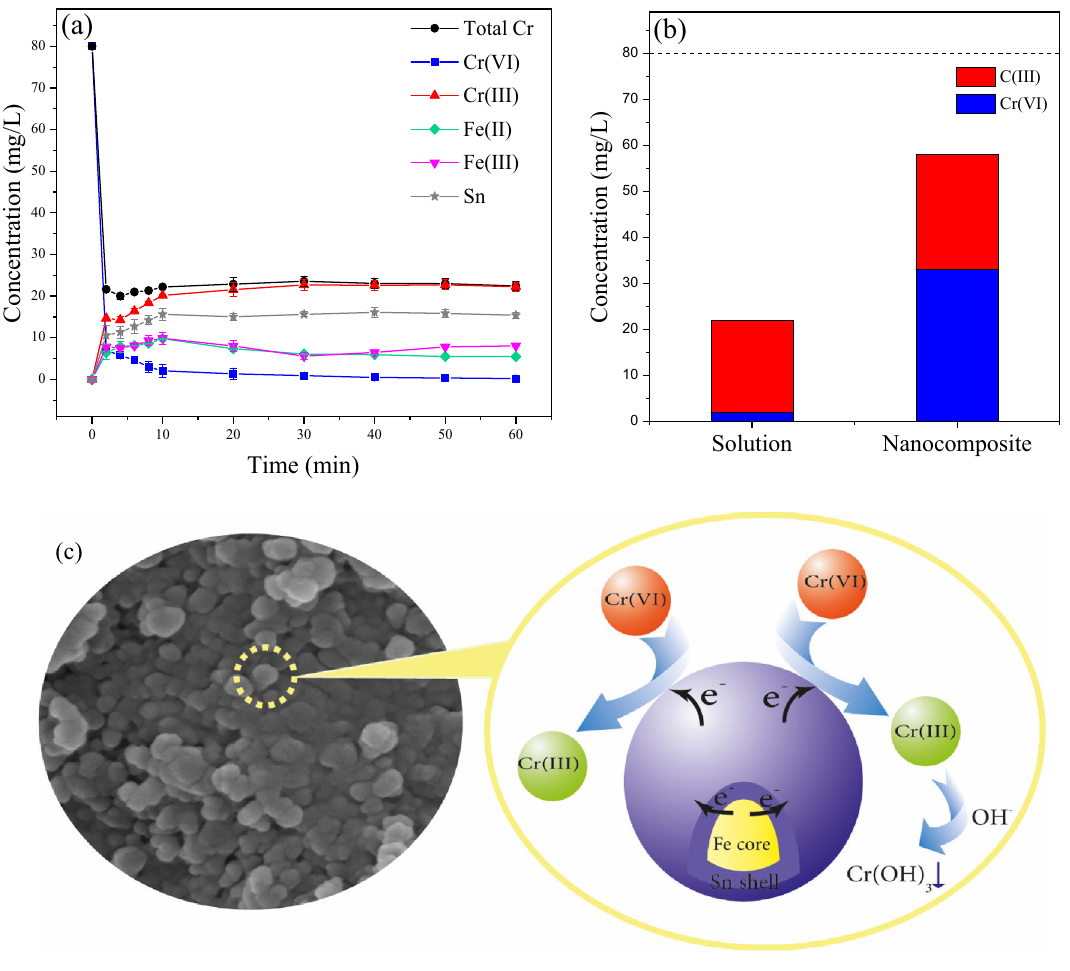
Figure 8. ( a ) The variation of Cr, Fe, and Sn concentrations in aqueous solution (initial Cr(VI) concentration: 80 mg/L, temperature: 30 °C, pH: 5, adsorbent dosage: 2 g/L) ( b ) valence states of Cr in aqueous solution and nanocomposite after Cr(VI) removal process ( c ) Proposed mechanism of Cr(VI) removal by